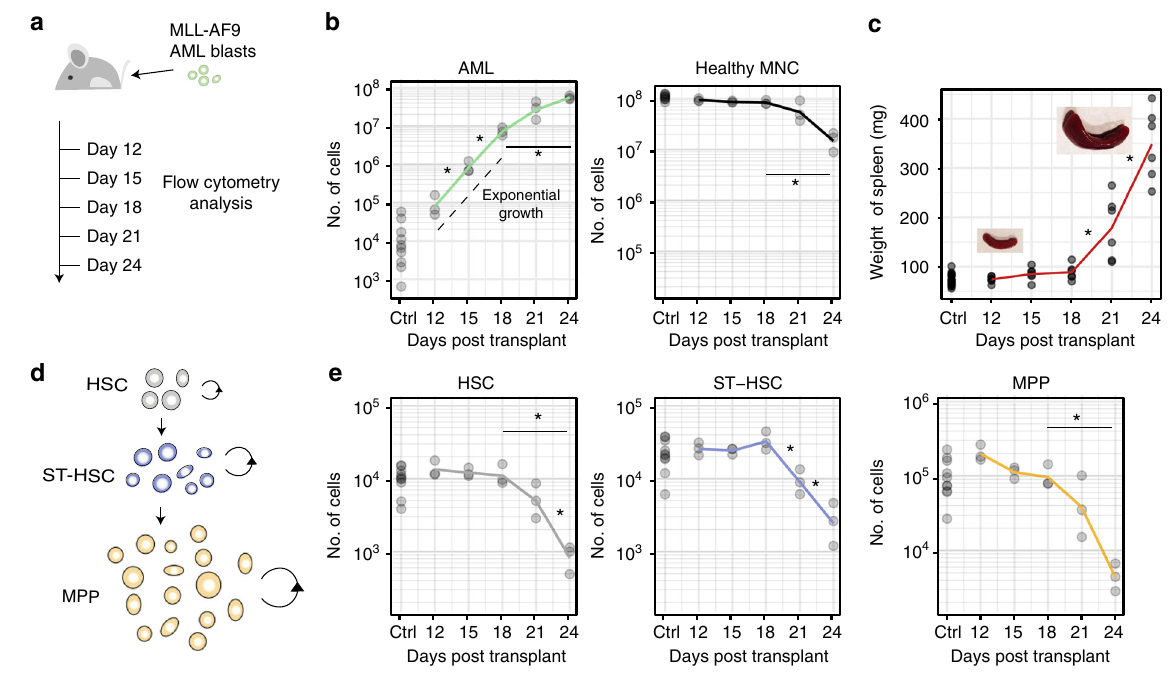
Fig. 1 Population dynamics of healthy and malignant haematopoietic cells as leukaemia progresses. a Cohorts of mice were injected i.v. with 100,000 MLL- AF9 AML blasts at day 0. Control and diseased mice were culled at days 12, 15, 18, 21 and 24, for fl ow cytometry analysis of BM cells (tibeas, femurs and ileac crest bones). b Between days 18 and 24, as AML cell numbers grow in the BM ( p = 0.003, Welch two-sample t -test), mononuclear cell counts decrease signi fi cantly ( p = 5.43e − 04, Welch two-sample t -test). c Spleen weights increase following AML cells injection, slowly at fi rst and signi fi cantly by day 21 ( p = 0.016, Welch two-sample t -test) and day 24 ( p = 0.001, Welch two-sample t -test). d At the apex of the haematopoietic cascade are HSCs, ST- HSCs and MPPs. Cells in each population proliferate (circular arrows) and differentiate into the downstream population (straight arrows). e Quanti fi cation of HSC (LKS CD150 + CD48 − /low ), ST-HSC (LKS CD150 - CD48 − /low ) and MPP (LKS CD48 + ) cell numbers as disease progresses. A signi fi cant reduction in population size was observed between days 18 and 24 in all populations ( p = 0.04 HSCs, p = 0.03 ST-HSCs and p = 0.046 MPPs, Welch two-sample t - test); n = 15 control in total and 3 leukaemic mice per time point analysed, apart for c where 4 – 6 spleens/time point are shown. Results from one cohort shown, with equivalent results obtained from two other independent